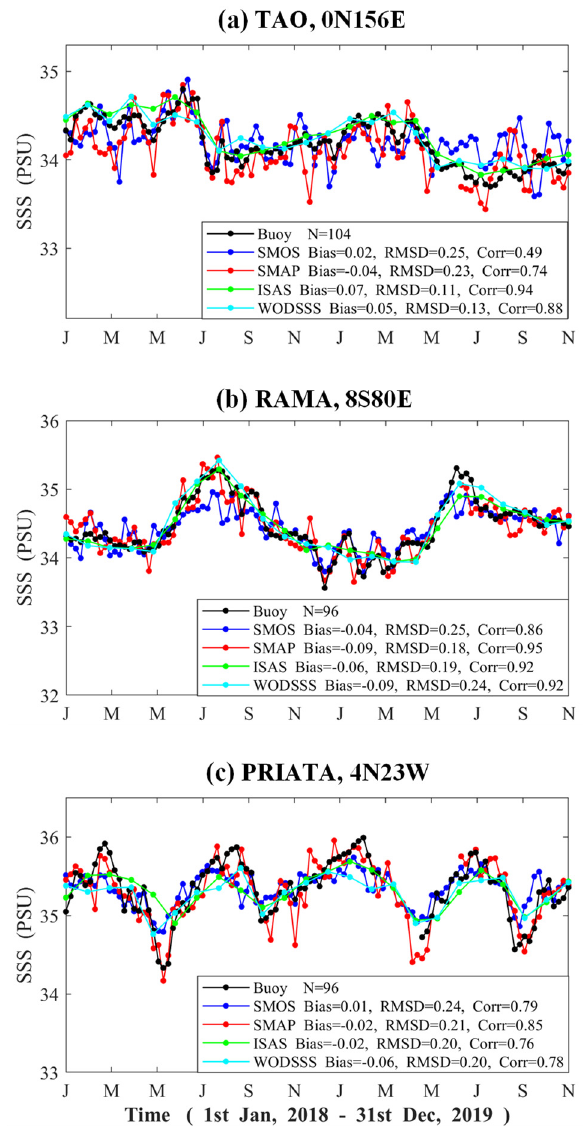
Figure 11. Time series of ( a ) buoy salinity at 1 m depth (black), collocated daily SMOS (blue) and 8-day SMAP (red), SSS plotted with monthly in situ data from WODSSS (azure) and ISAS-20 (green). Data are from ( a ) TAO at 0° N, 156° E, ( b ) RAMA at 8° S, 80° E, ( c ) PIRATA at 4° N, 23° W for the period from 1 January 2018 to 31 December 2019.